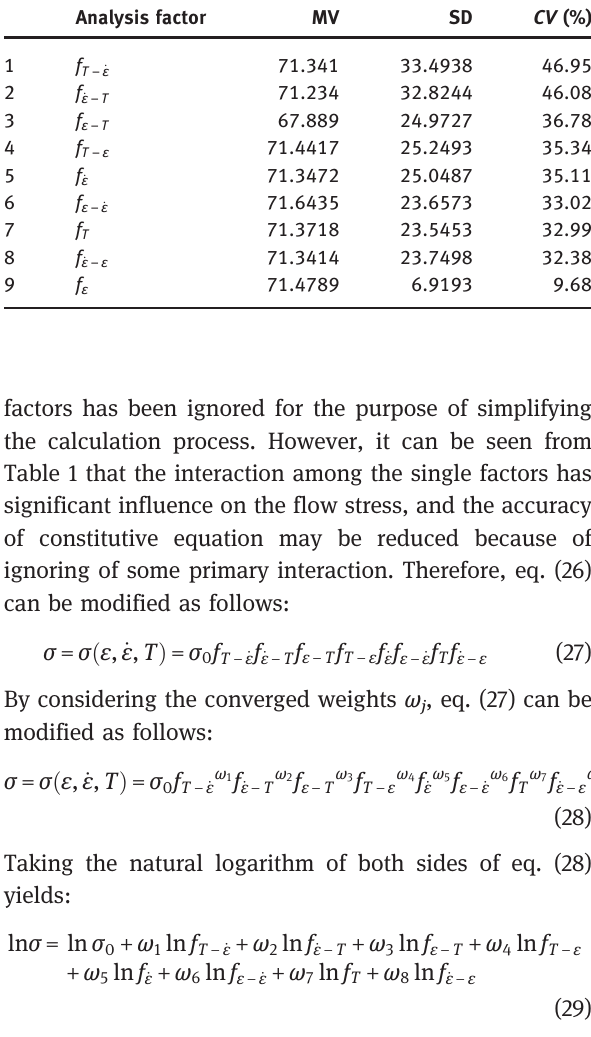
Table 1: The order of CV about analysis factors. Analysis factor